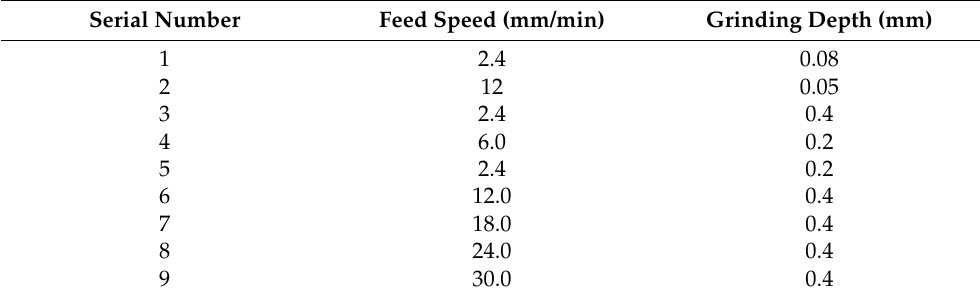
Table 1. Processing test